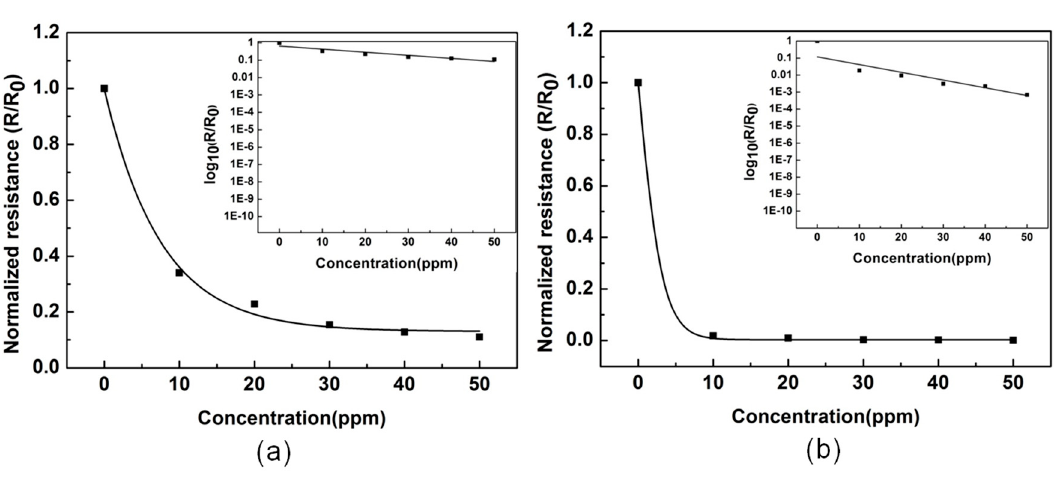
Table 1. Sensors based on nanomaterials detects ammonia.